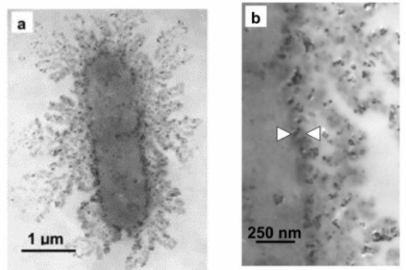
Figure 8. TEM images of E. coli cell treated with 50 µ g · cm − 3 of silver nanoparticles in liquid LB medium for 1 h ( a ) and an enlarged view of the membrane of this cell ( b ). Reprinted with permission from ref. [143]. Copyright 2004